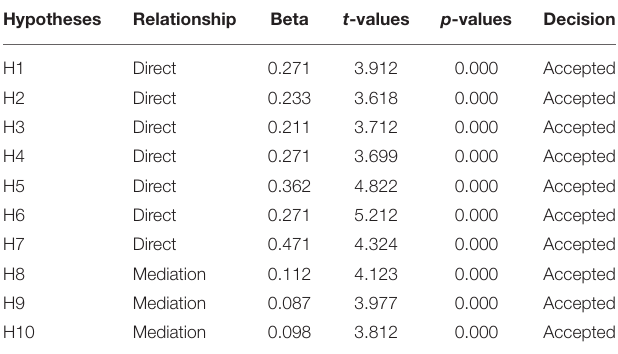
TABLE 5 | Standardized path